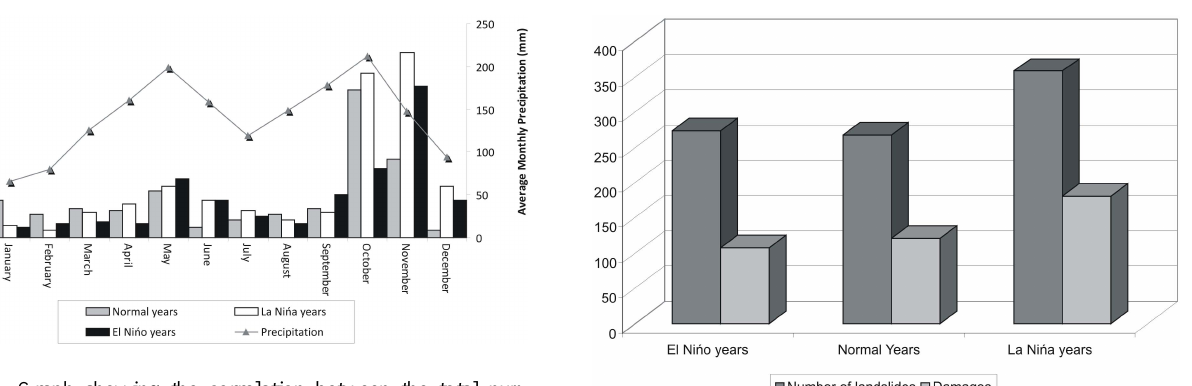
Fig. 6. Graph showing the correlation between the total num- ber of landslides per month, classified according to the average monthly precipitation and weather pattern. Precipitation informa- tion is based on the monthly average calculated over a 30-year pe- riod (1971–2000) (WMO 3 ).